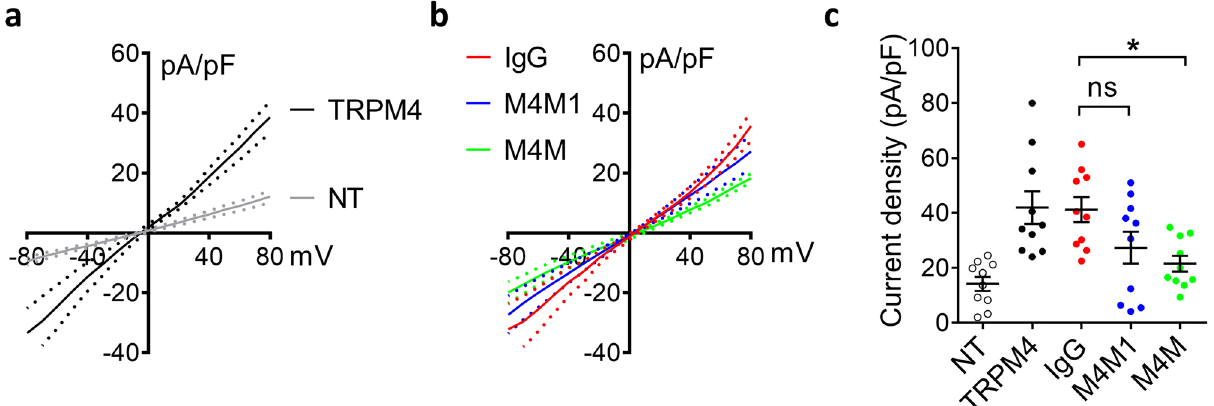
Figure 3. M4M blocks human TRPM4 currents. ( a ) The current voltage relationships of TRPM4 were obtained from HEK 293 cells transfected with human TRPM4 and compared to control HEK 293 cells without transfection (NT). Ramp protocols were applied from − 80 to + 80 mV with a holding potential at 0 mV. The data were presented as means ± s.e.m. ( b ) Comparison of human TRPM4 currents after the treatments of control IgG, M4M1 and M4M. Human TRPM4-transfected HEK 293 cells were incubated with control mouse IgG, M4M or M4M1 at a concentration of 20.8 μg/ml for 30 min before patch clamping. ( c ) Summary of current densities at + 80 mV. For ( a – c ), n = 10 cells for each group. *p < 0.05, ns no significance, One-way ANOVA with Bonferroni’s post hoc analysis.